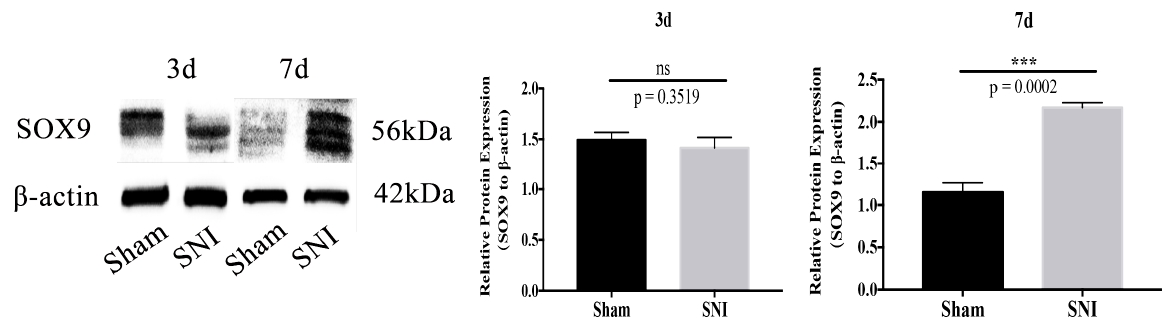
Figure 9. Expression of Sox9 protein in SGCs (ns: no statistical significance; *** p = 0.0002).